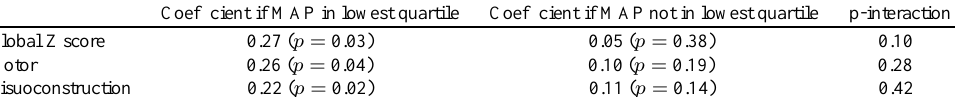
Table 4 Interaction between lowest MAP quartile and EF (per 10% increase in EF) in the prediction of cognitive Z-score. Regression coefficients and their individual p-values are shown for the association between EFand Z-score for individuals with MAP in the lowest, versus in any other quartile (columns 1 and 2)